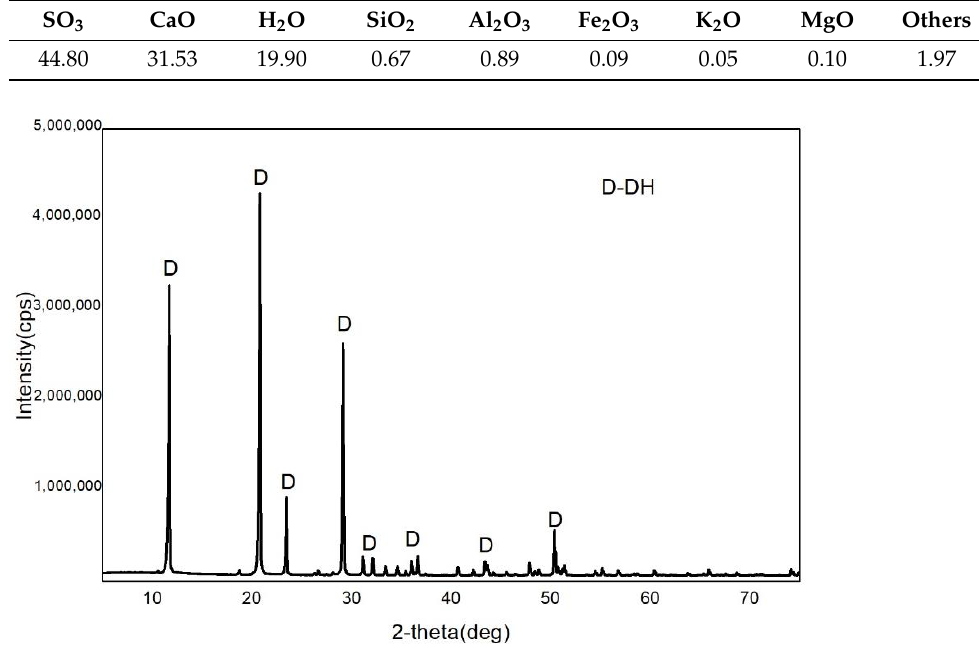
Figure 1. X-ray diffraction (XRD) pattern of the FGD gypsum.